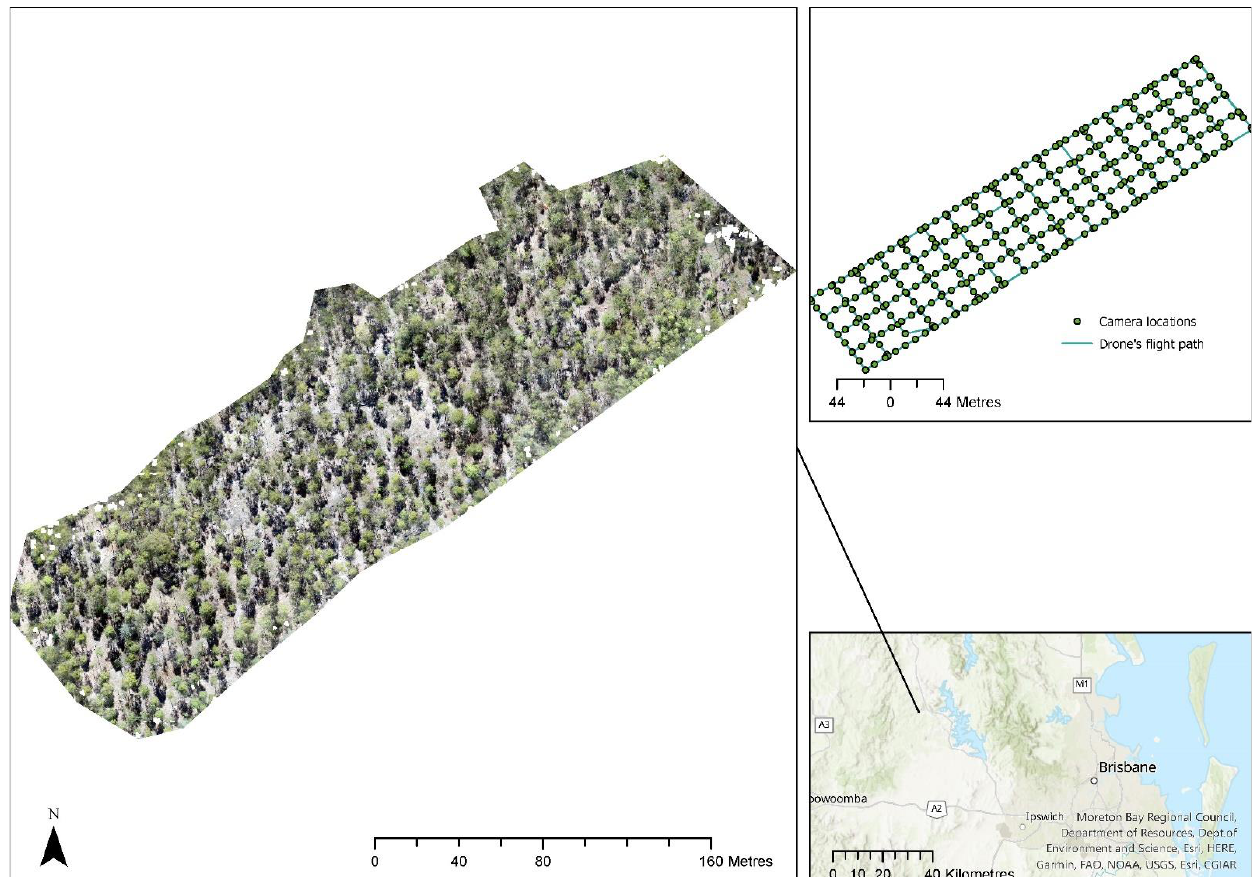
Figure 8. Location of site 2 selected for analysing drone data.